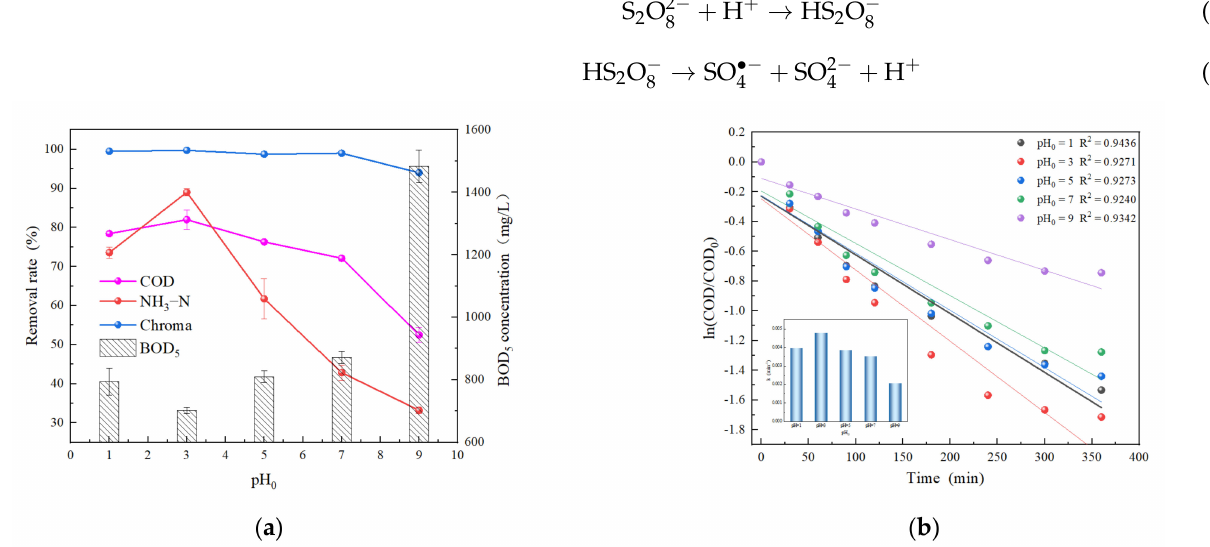
Figure 2. ( a ) Effects of initial pH on COD, NH 3 -N, chroma removal rate, and BOD 5 content. ( b ) Pseudo-first-order kinetic models of COD degradation at different initial pH values. (Initial pH: 3.0; PS/12COD ratio: 1; ZVI dosage: 1.5 g/L; current density: 62.5 mA/cm 2 ; reaction time: 6